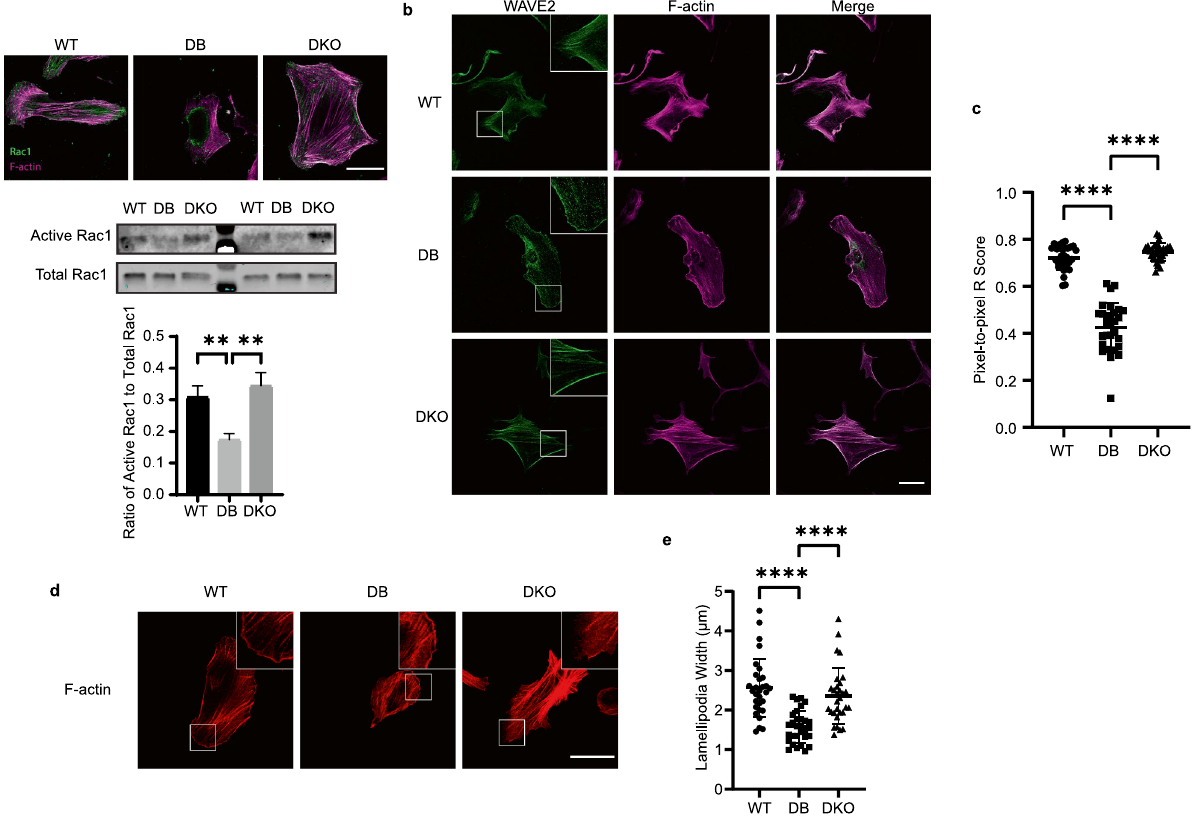
Figure 5. Dysfunction in diabetic fibroblasts is associated with lack of active Rac1 and WAVE2. ( a ) Top, representative IF images of Rac1 and F-actin show Rac1 localization in relation to F-actin. Scale bar = 40 μm. Middle, representative western blot of GTP-bound Rac1 and total Rac1 shows lack of active Rac1 in DB fibroblasts. Full blots are available in Supplementary Fig. 4. Bottom, densitometry analysis shows significant decrease of active Rac1 in DB when normalized to total Rac1 signal (n animals = 3 per group). One-way ANOVA followed by Tukey’s post hoc test and multiple comparison test. *p < 0.05. ( b ) Representative IF images of dermal fibroblasts stained for WAVE2 and F-actin show co-localization of WAVE2 signals and F-actin. Scale bar = 40 μm. ( c ) Quantification of R score between WAVE2 signals and F-actin signals show differences across the three genotypes (n animals = 3 per genotype, n cells = 10 per animal). One-way ANOVA followed by Tukey’s post hoc test and multiple comparison test. ****p < 0.0001. ( d ) Representative IF images of dermal fibroblasts were stained for F-actin. Scale bar = 40 μm. ( e ) Measurements of lamellipodia width show decreased width in diabetic fibroblasts. Data were obtained by averaging lamellipodia width within each cell (n animals = 3 per genotype, n cells = 10 per animal). One-way ANOVA followed by Tukey’s post hoc test and multiple comparison test. ****p <